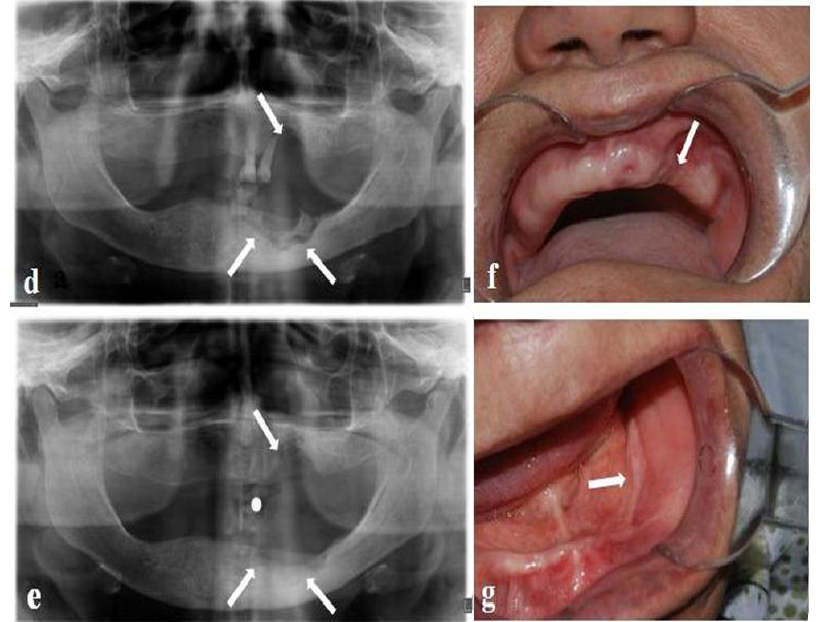
Figure 1. Clinical photographs and radiographic images from Case Report 1. (d) Panoramic radiograph taken at second visit confirmed the progression of the osteonecrosis to fracture in five weeks. Note the sequestrum in the left mandible; (e) The panoramic radiograph taken 11 months after the patient’s first visit to our department showing the standardized area; (f,g) Photographs of the patients’ jaws showing two examples each of upper and lower jaw complete response to